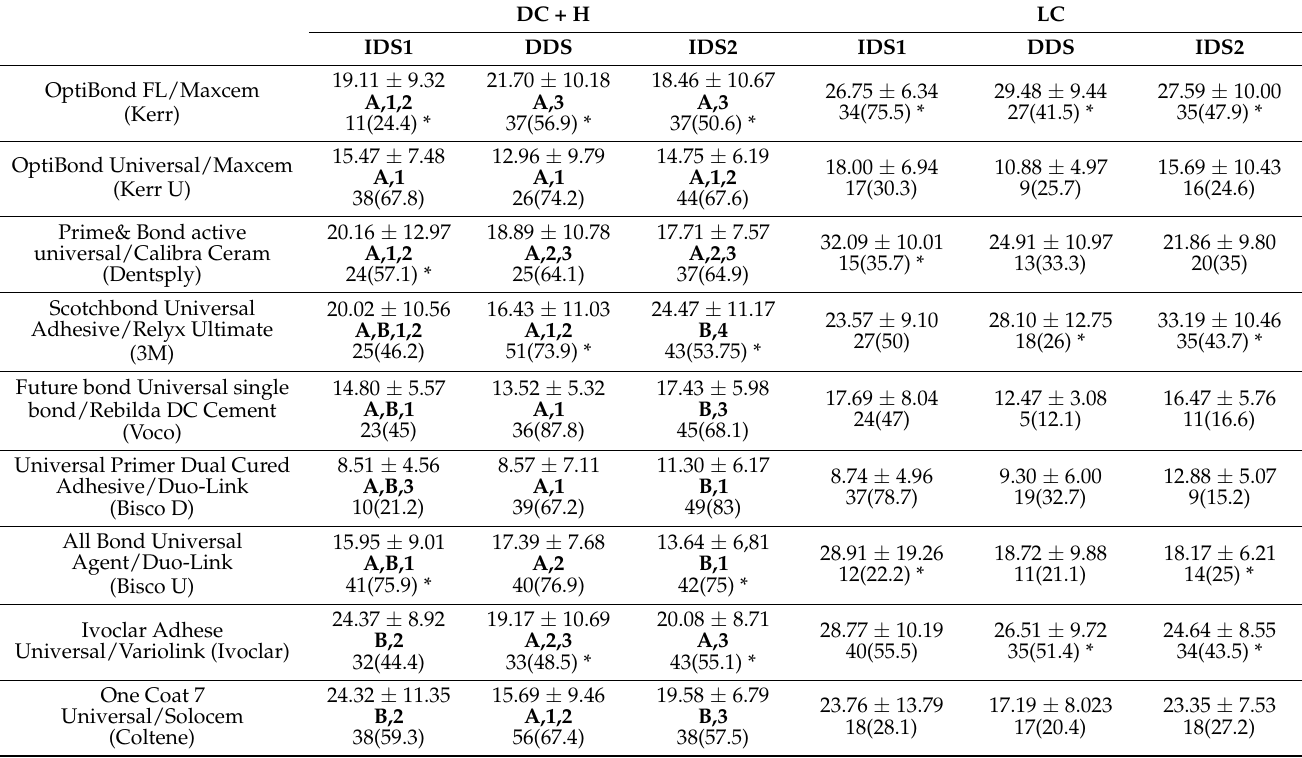
Table 2. Means ± standard deviations of micro-tensile bond strength ( µ TBS) (MPa) and number of beams (percentage) of each failure